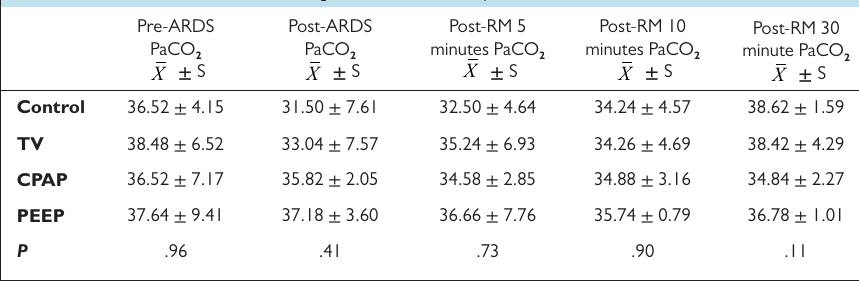
Figure 2. Change of the intracranial pressure values. ICP, intracranial pressure; ARDS, acute respiratory distress syndrome; TV, tidal volume; CPAP, continuous positive airway pressure; PEEP, positive end- expiratory pressure; RM, recruitment maneuver. Table 3. Distribution of Mean PaCO Values of the 2